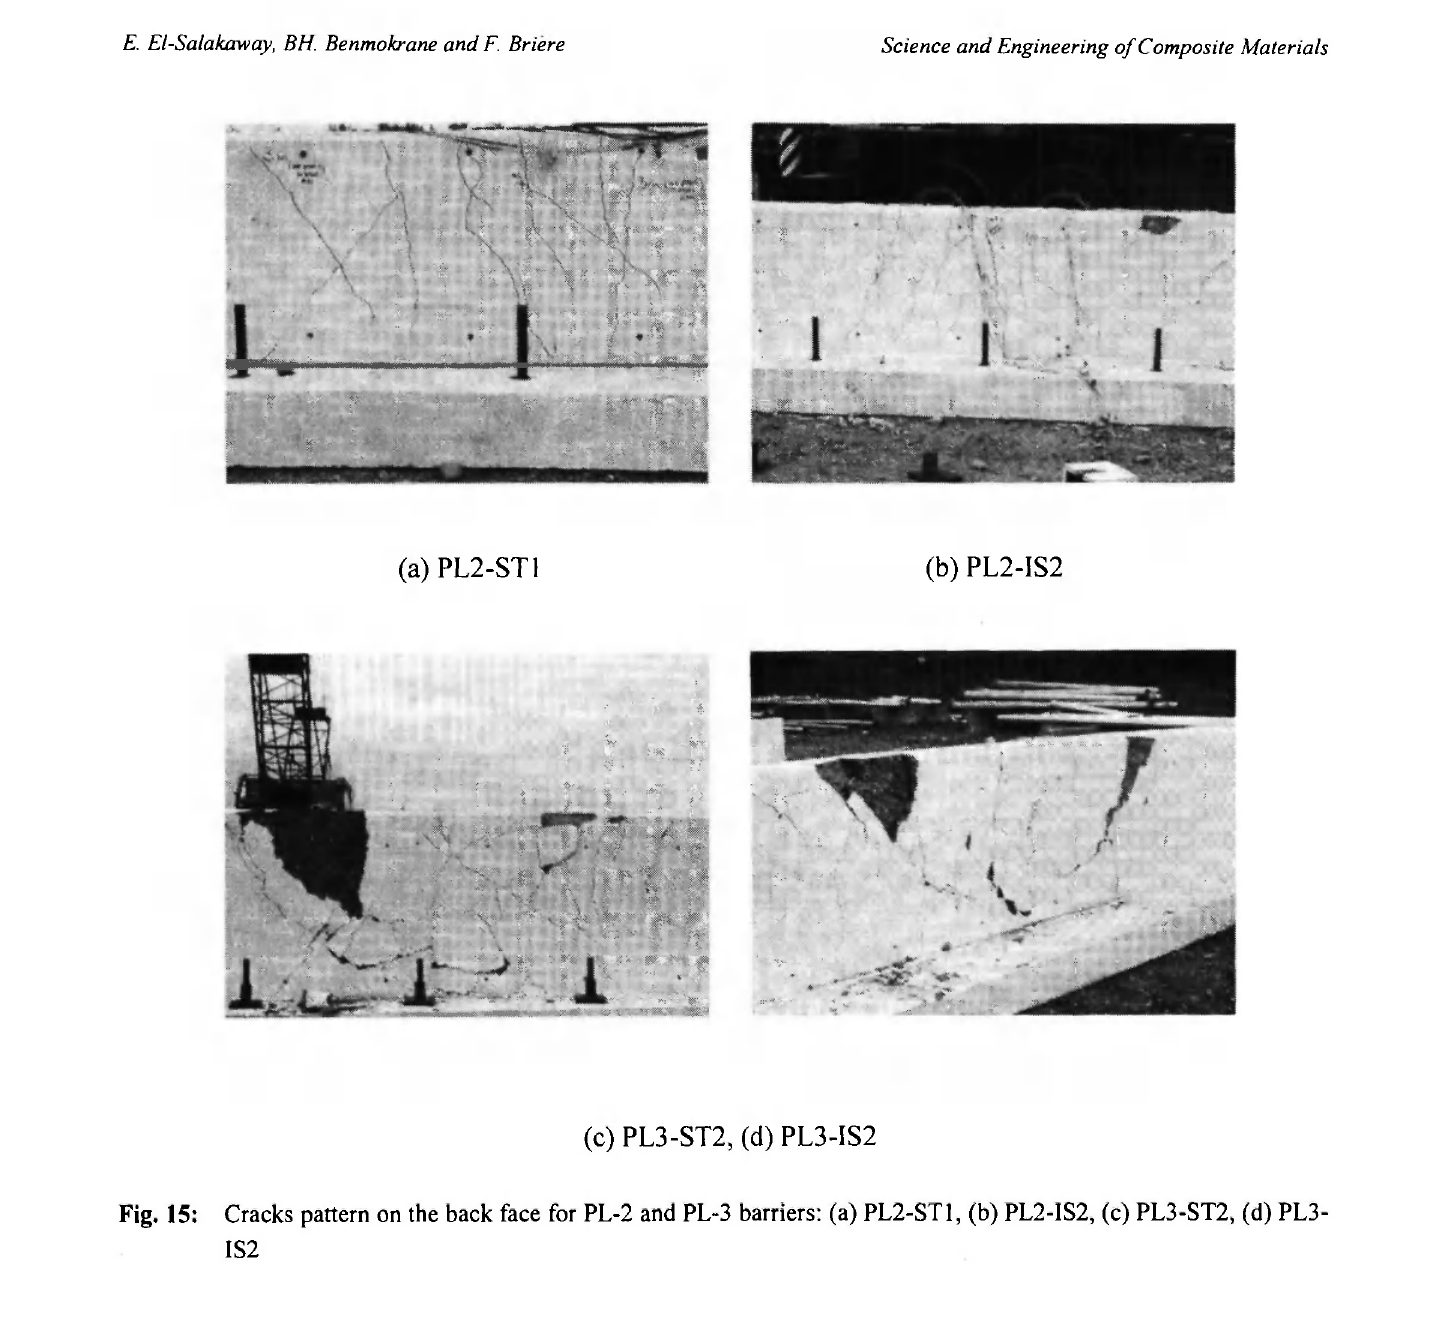
Fig. 15: Cracks pattern on the back face for PL-2 and PL-3 barriers: (a) PL2-ST1, (b) PL2-IS2, (c) PL3-ST2, (d)